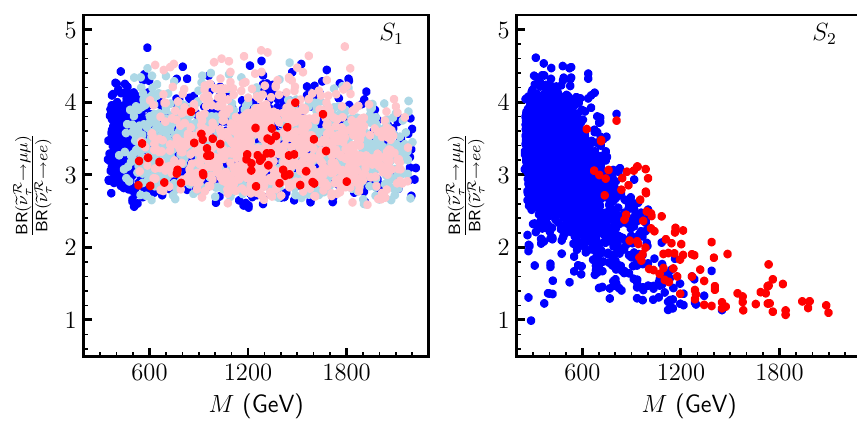
Fig. 6 Ratios of the branching fractions of (cid:2) ν τ → μμ and (cid:2) ν τ → ee for scan S 1 (left) and scan S 2 (right). The color code is the same as in Fig. 5